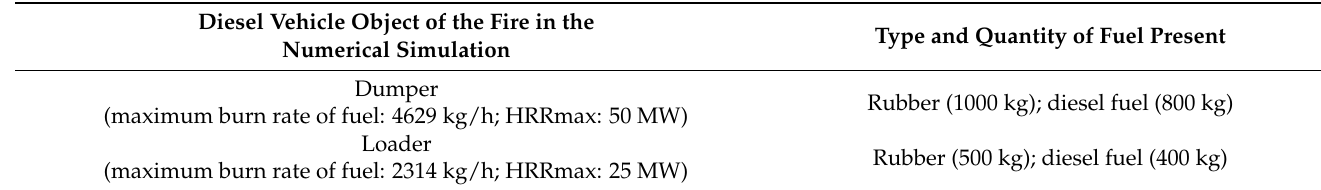
Table 1. Quantity of combustible materials evaluated on the two diesel vehicles that are subject to fire in the numerical simulations that reached maximum thermal